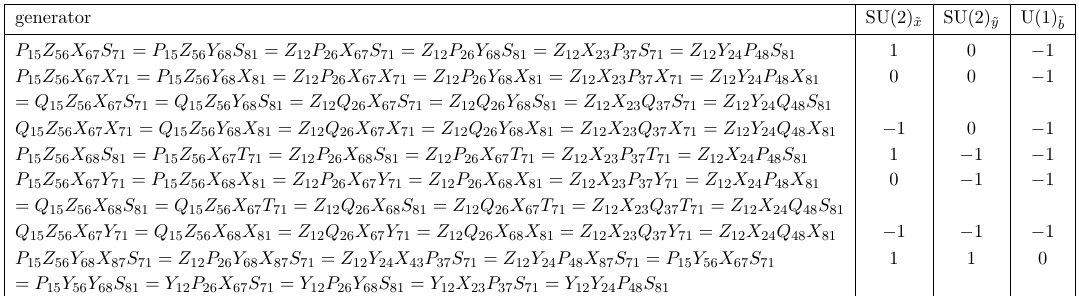
table 44 is a convex lattice polytope, which is reflexive. It is the dual of the toric diagram of Model 11 shown in figure 31. We also note that the 3 layers of points in the generator lattice in table 44 corresponds to the 3 sets that transform under [2; 1] b − 2 , [2; 2] and [2; 3] b 2 of the mesonic flavor symmetry. For completeness, table 45 and table 46 show the generators of Model 11 in terms of chiral fields with the corresponding mesonic flavor